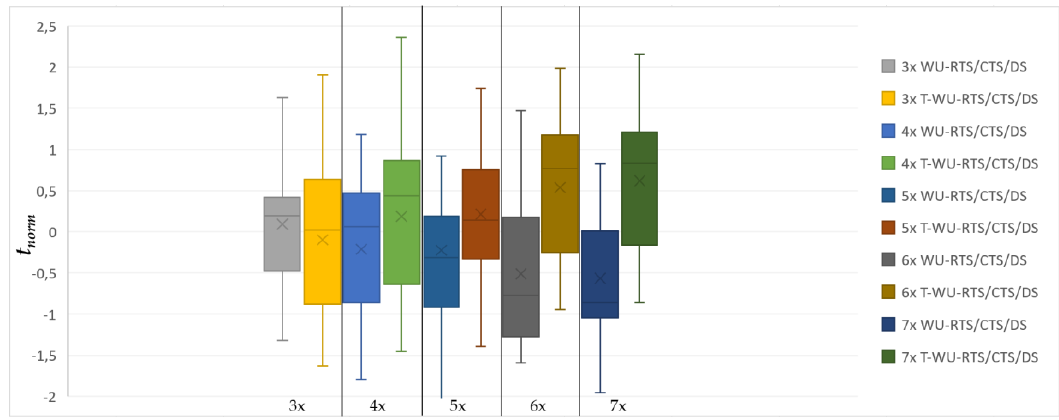
Figure 7. WU-RTS / CTS / DS and T-WU-RTS / CTS / DS comparison (X: ∆ x: number of nodes per the hop; Figure 7. WU-RTS/CTS/DS and T-WU-RTS/CTS/DS comparison (X: Δx: number of nodes per the hop; Y: t norm Y: t norm ).